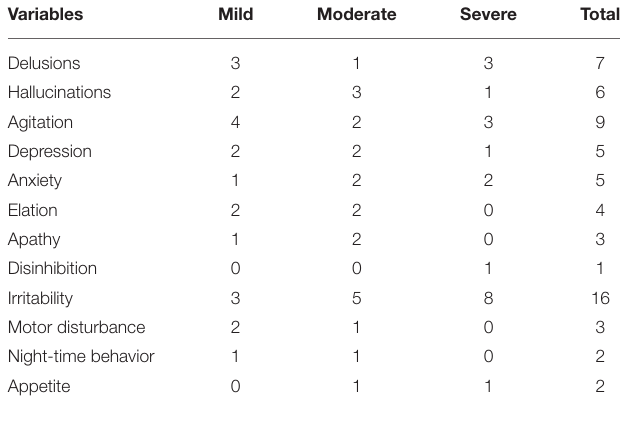
TABLE 3 | Psychiatric disorders of the patients.